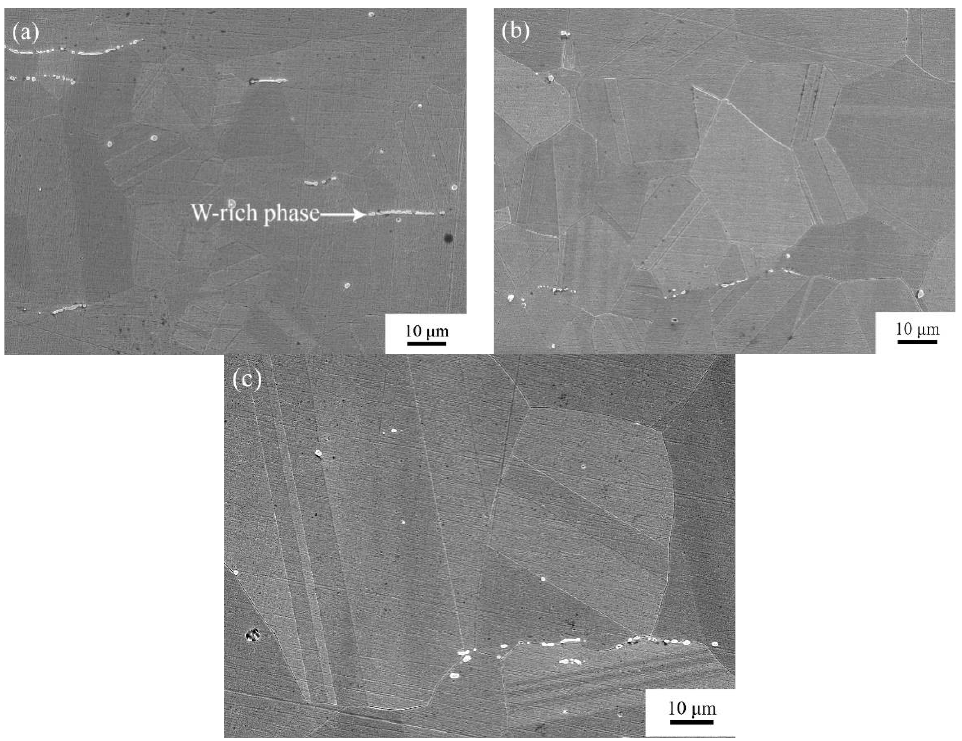
Figure 2. The microstructure of the Ni-36.6W-15Co sample after annealing at ( a ) 1100 °C, ( b ) 1150 °C and ( c ) 1200 °C for 60 min.